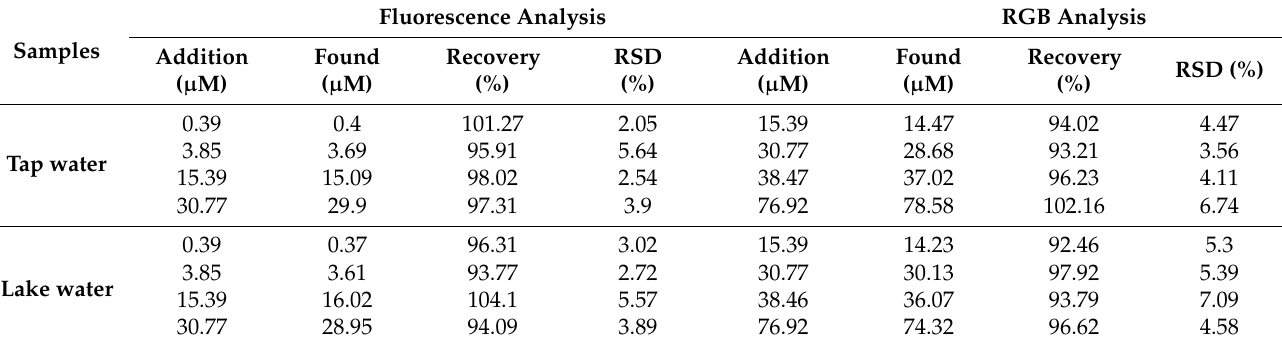
Table 1. Recovery of Al 3+ in spiked tap and lake water.